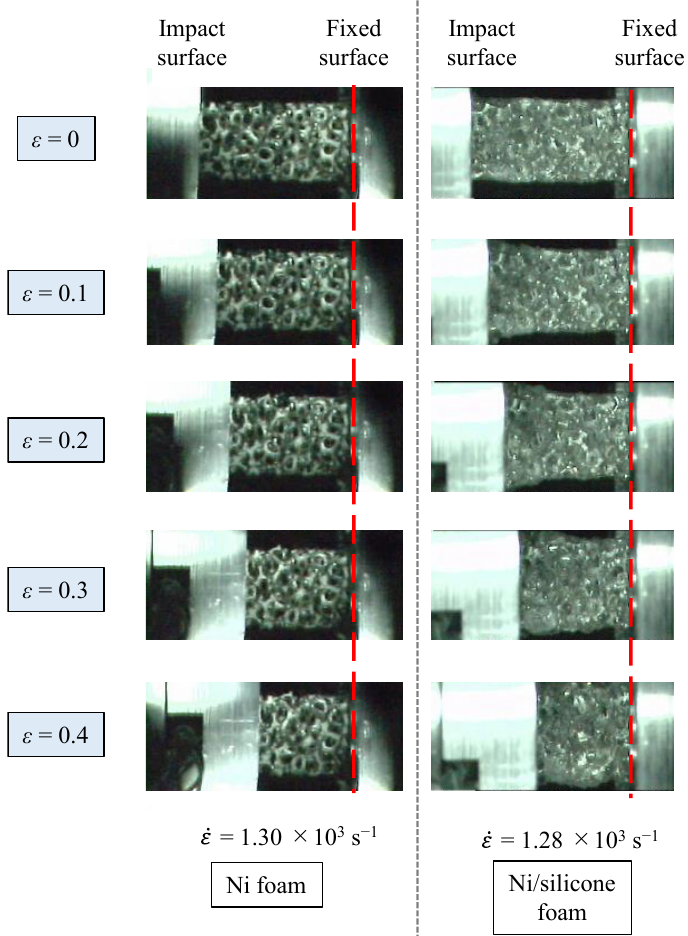
Figure 15. Deformation behavior of Ni foam and Ni/silicone foam at compression rate of approxi- mately 26.0 m/s.